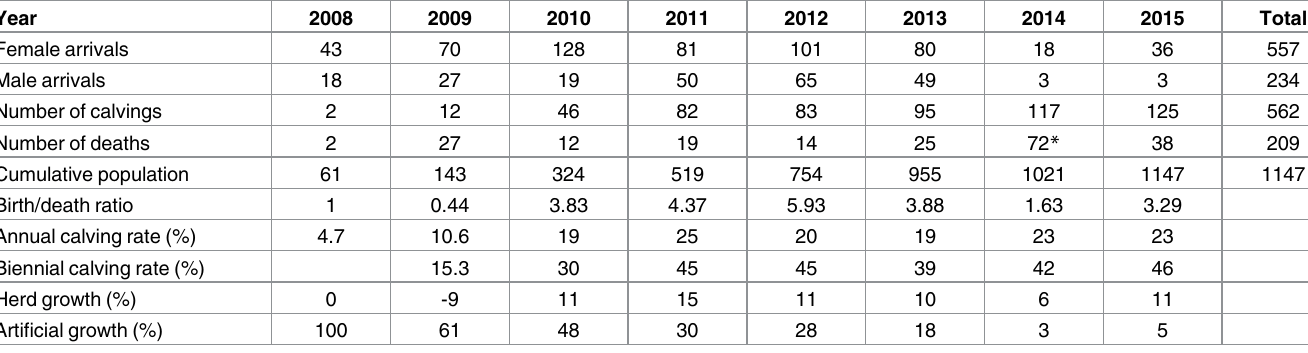
Table 1. Population growth parameters from